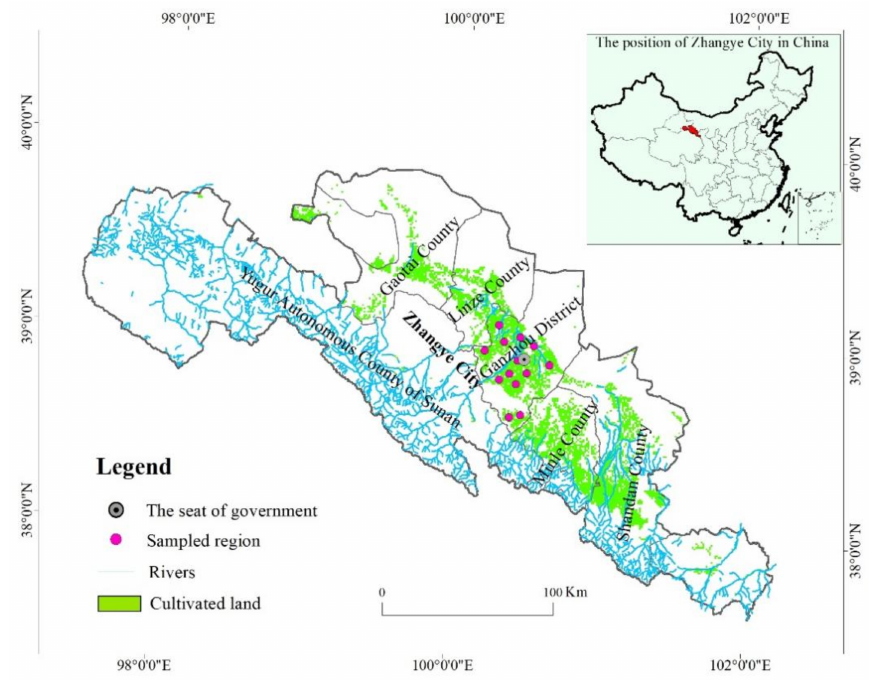
Figure 1. Overview of the study area and distribution of sampling